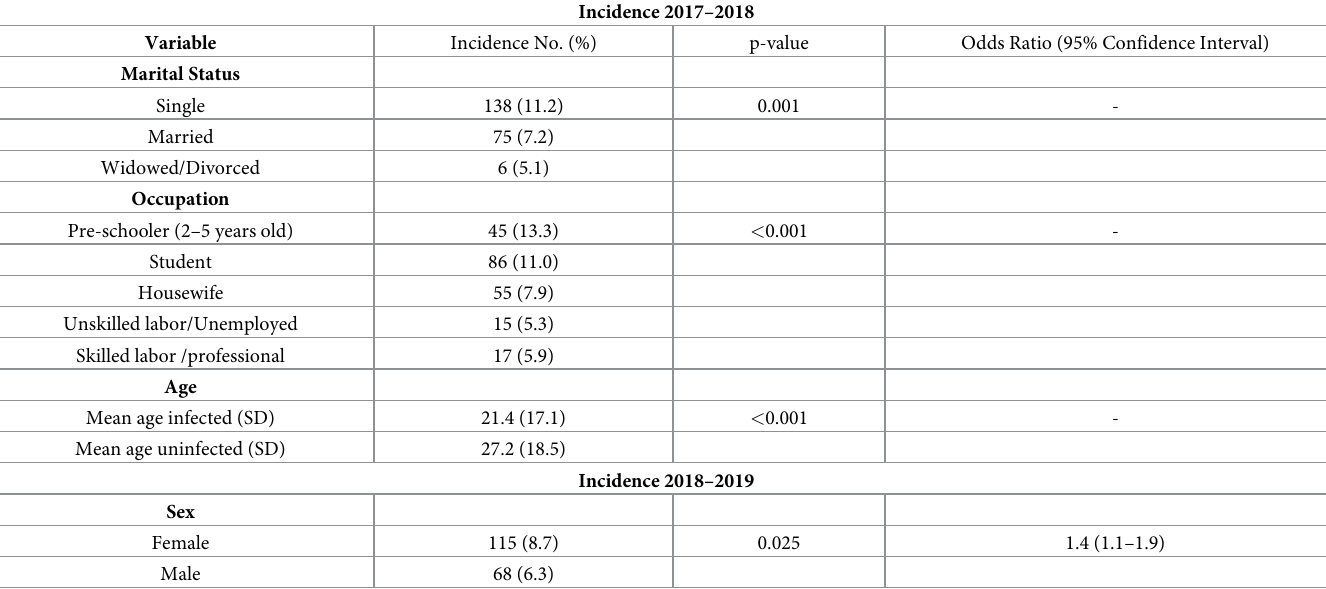
Table 3. Determinants of incidence among study participants, 2017–2019 in